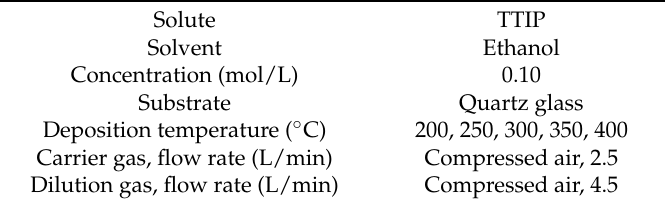
Table 1. Deposition condition of temperature dependence.